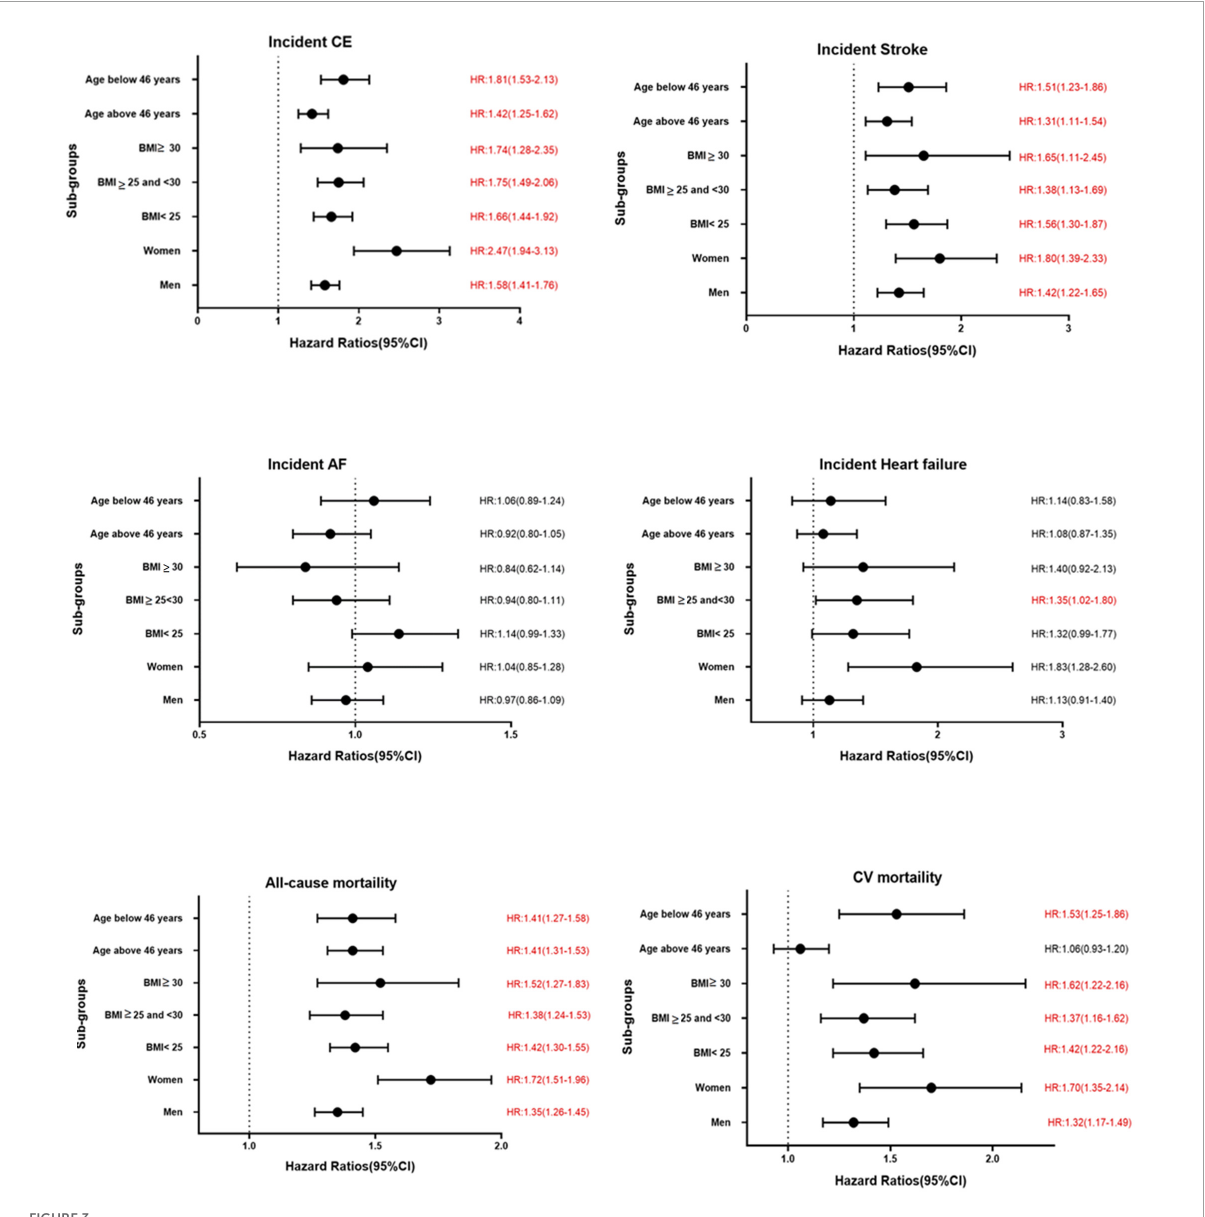
FIGURE3 Association between per unit increase of TyG index and various CVD outcomes in different sub-groups in MPP. Significant results are presented in